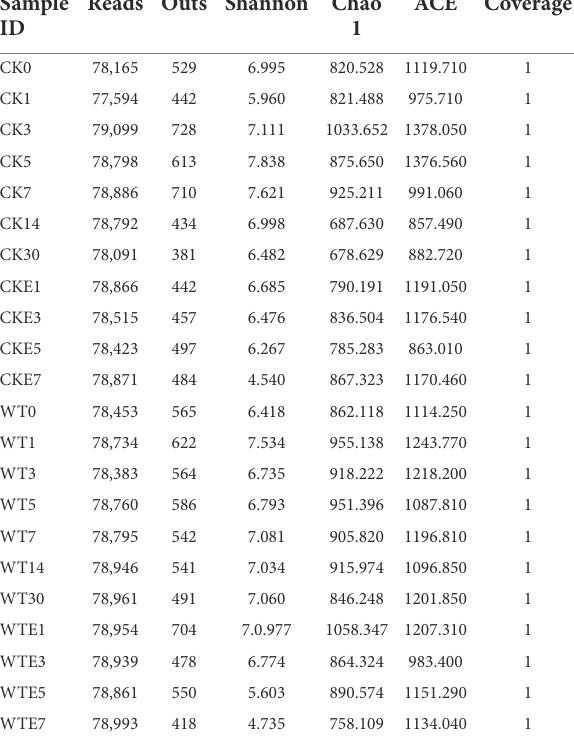
TABLE 4 Alpha diversity of fungal in king grass ensiling process and after exposure to air. Sample